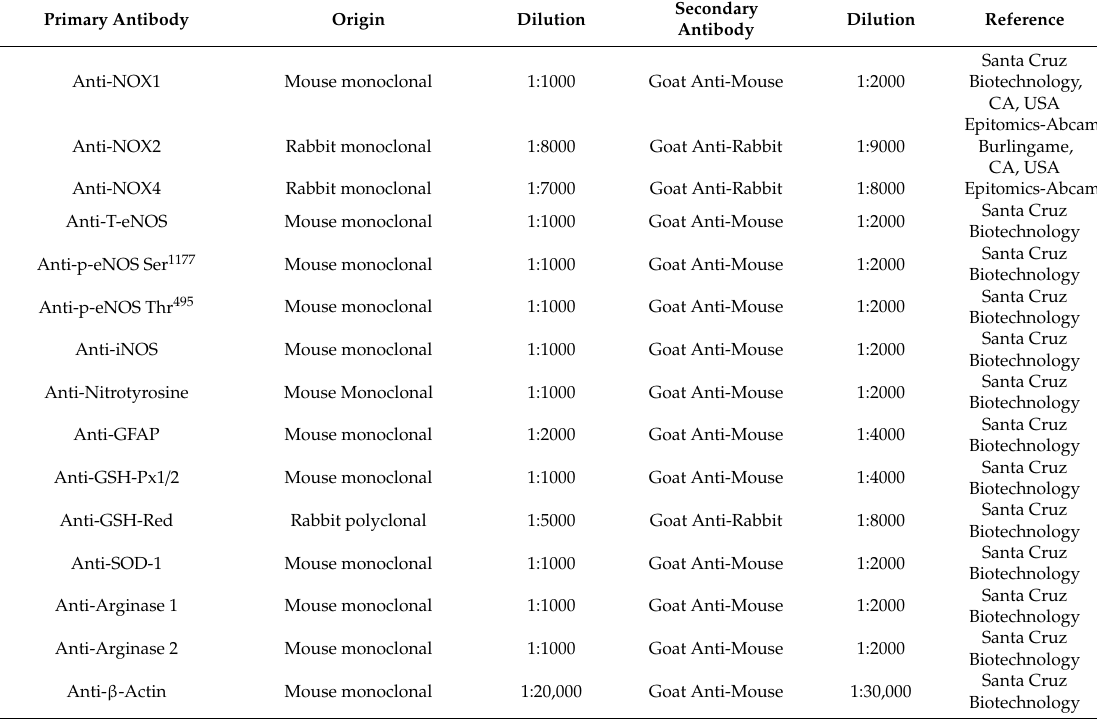
Table 3. Antibodies used for Western blotting